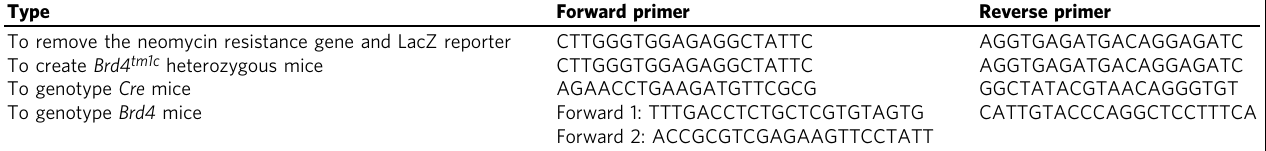
Table 3 Primers for genotyping transgenic mice for Cre and fl ox site